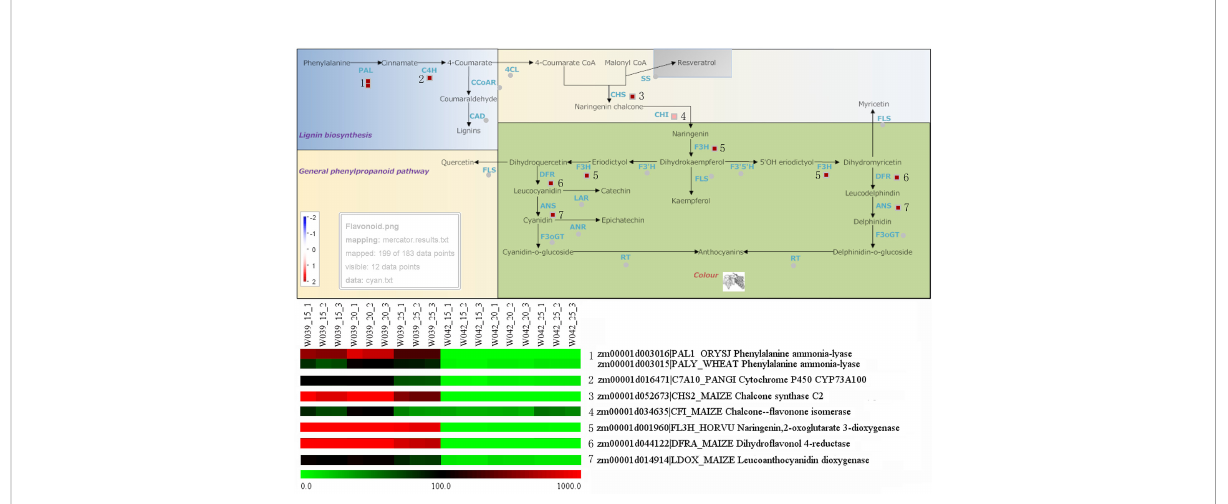
FIGURE 7 Identi fi cation of structural genes related to anthocyanins biosynthesis. The little squares in the pathway represented the LogFC values of W039 vs W042 which were calculated using the average values at 15, 20, and 25 DAP. The listed heatmap exhibited the FPKM value for each